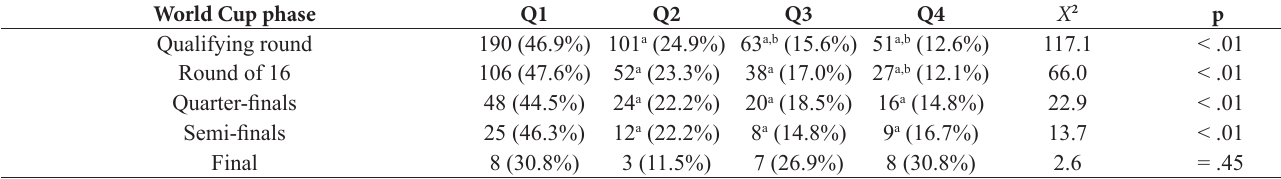
Table 2. Number of players born who effectively play according to each tournament phase ( n ; %). World Cup phase